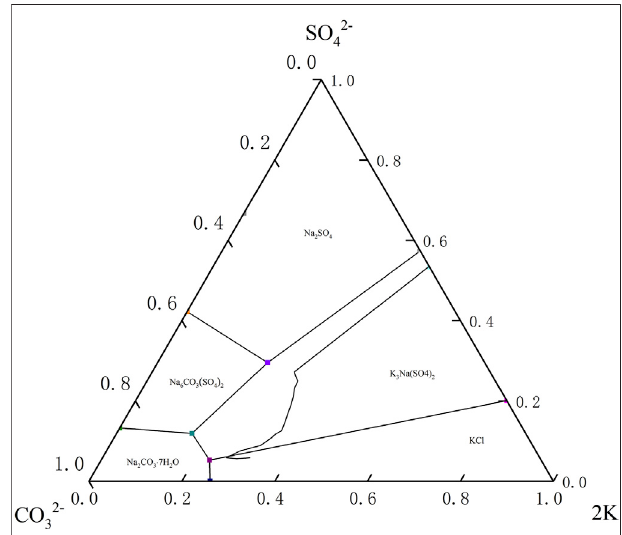
FIGURE 10 | The route diagrams of isothermal evaporation of brine taken from Zabuye Salt Lake at 15 ° C in spring. FIGURE 11 | The route diagrams of isothermal evaporation of brine taken from Zabuye Salt Lake at 25 ° C in autumn.